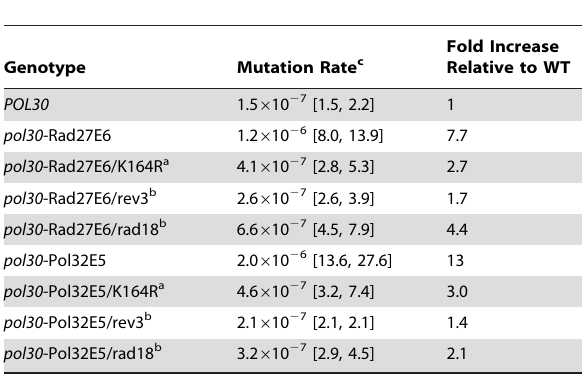
Table 2. Spontaneous mutation rate analysis at the CAN1